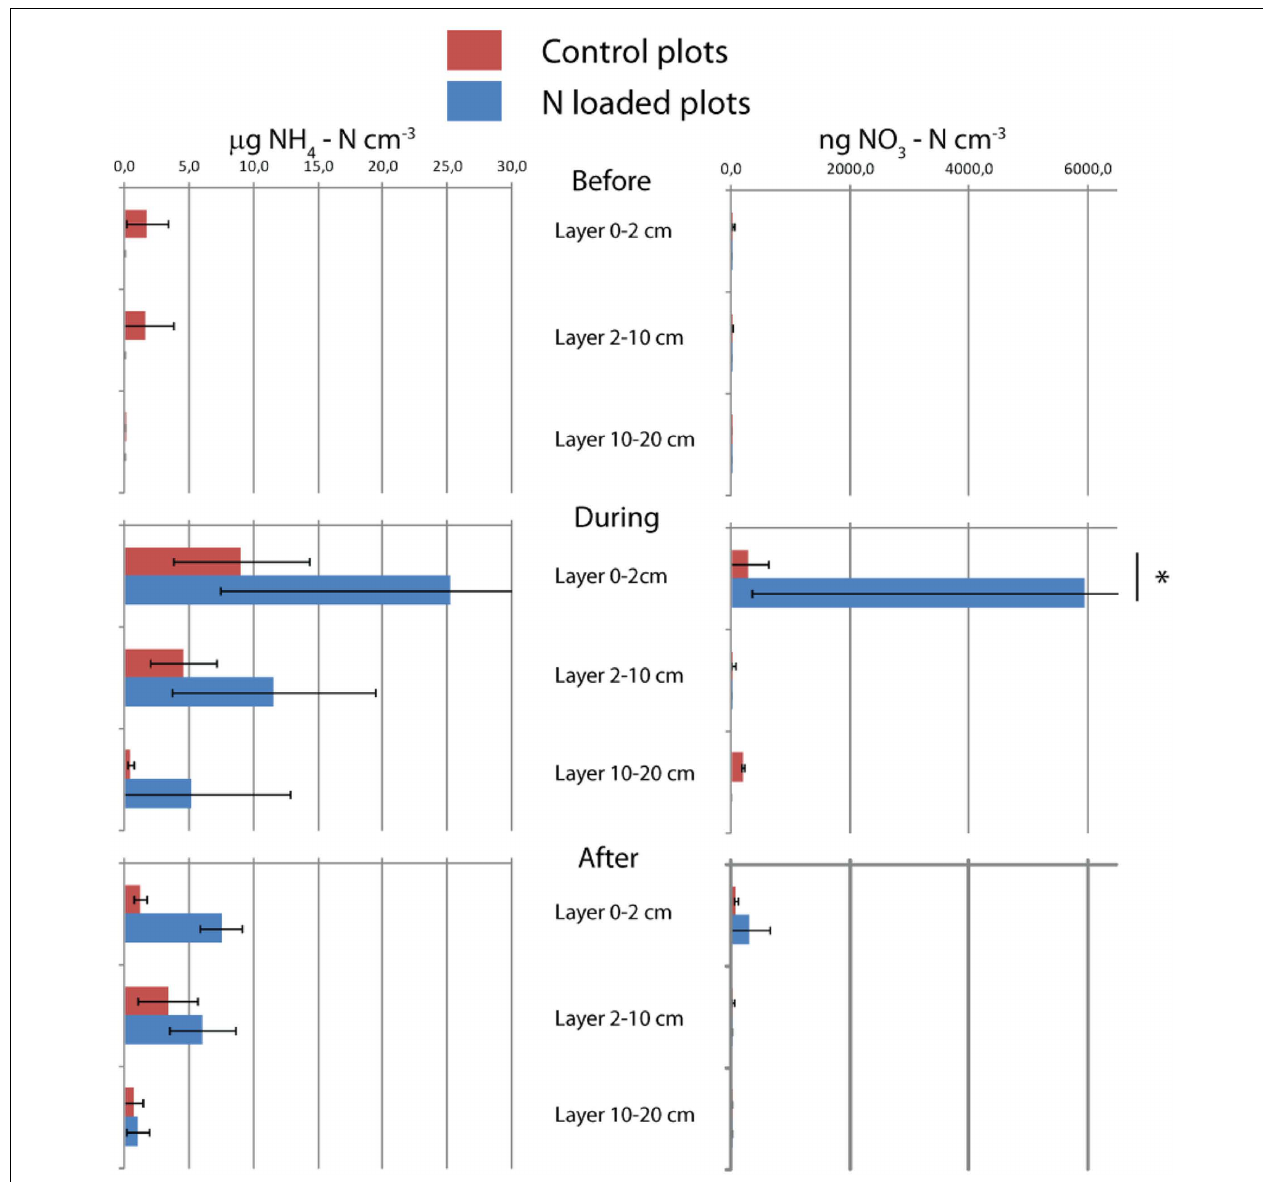
FIGUREA2 | Nitrogen content of soil. Means and SDs of triplicates are shown.The asterisk indicates the difference between control and manipulation ( P < 0.01).